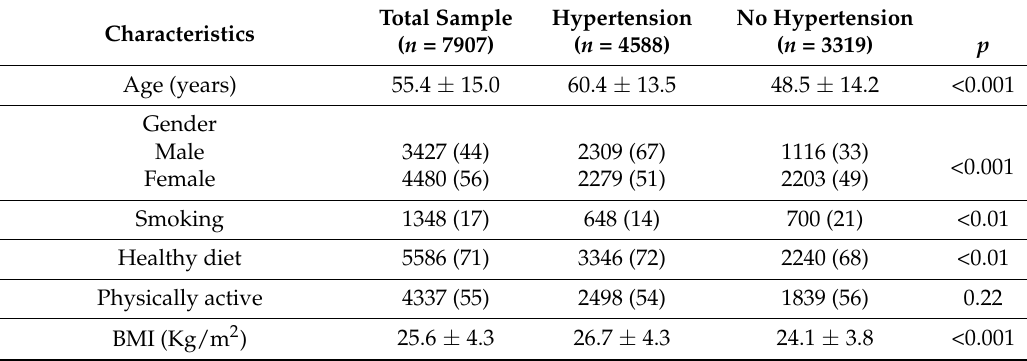
Table 1. Characteristics of the study population according to hypertension